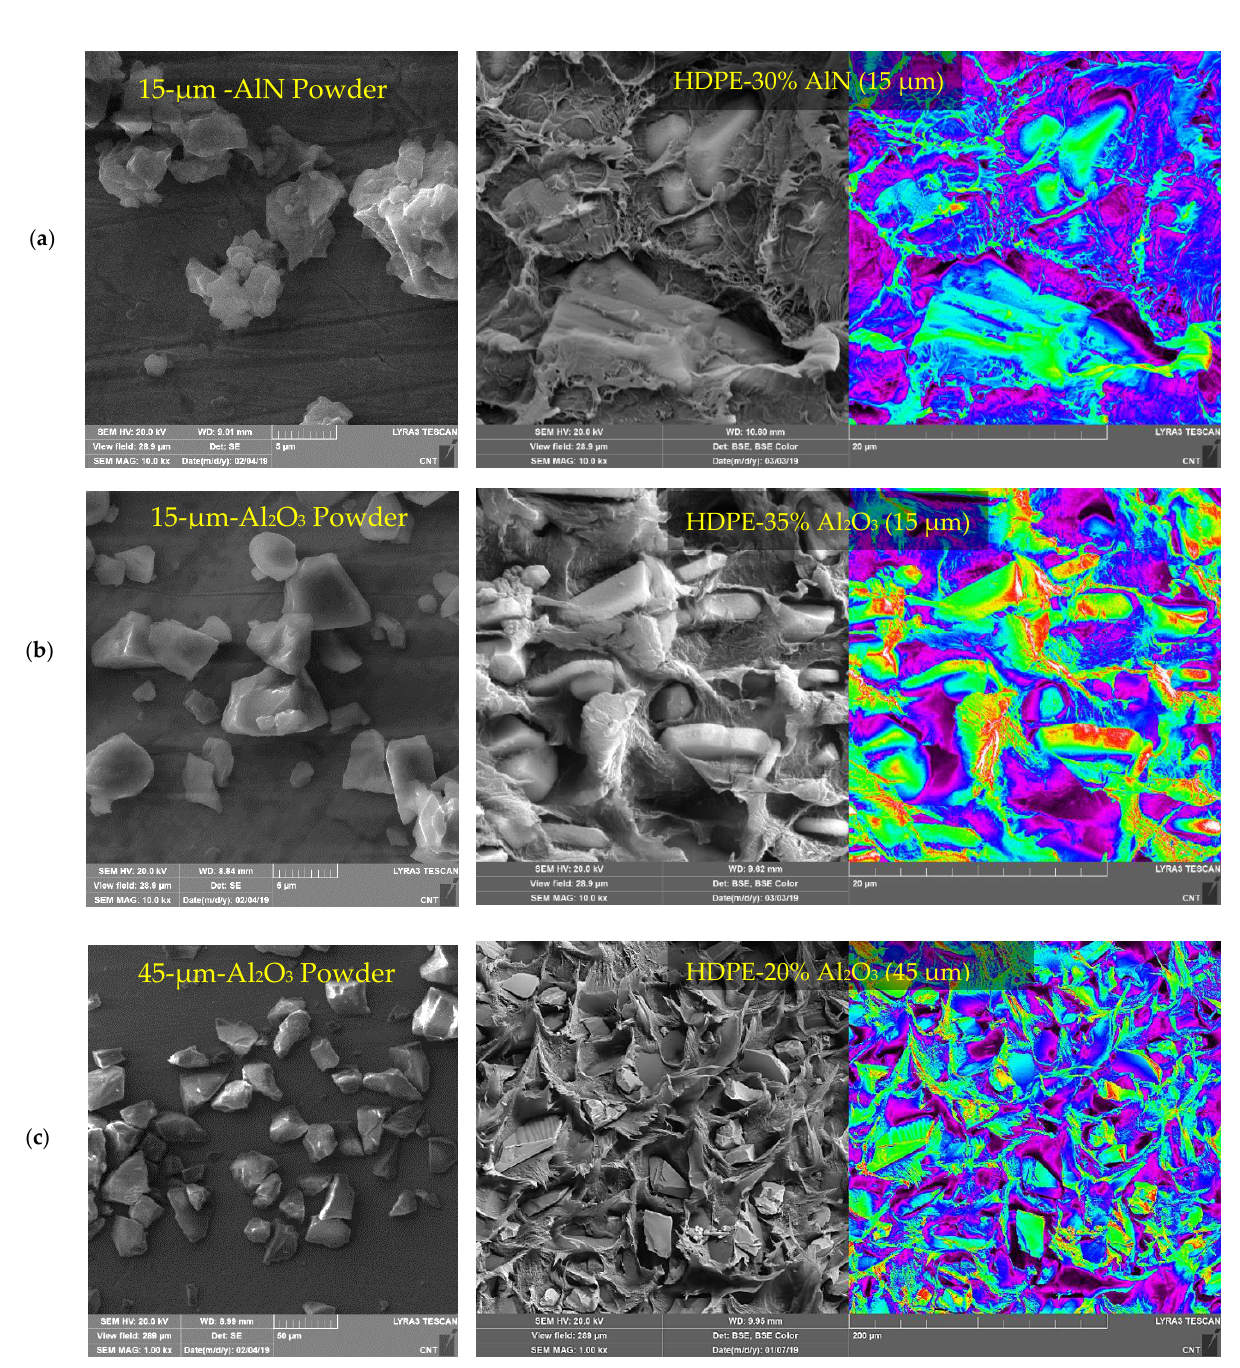
Figure 6. Characterization of ceramic fillers and fractured HDPE-based composites. FESEM images of HDPE/ceramic composite at ( a ) 30 vol% AlN (15 µm) loading, ( b ) 35 vol% Al 2 O 3 (15 µm) loading, and ( c ) 20 vol% Al 2 O 3 (45 µm) loading.